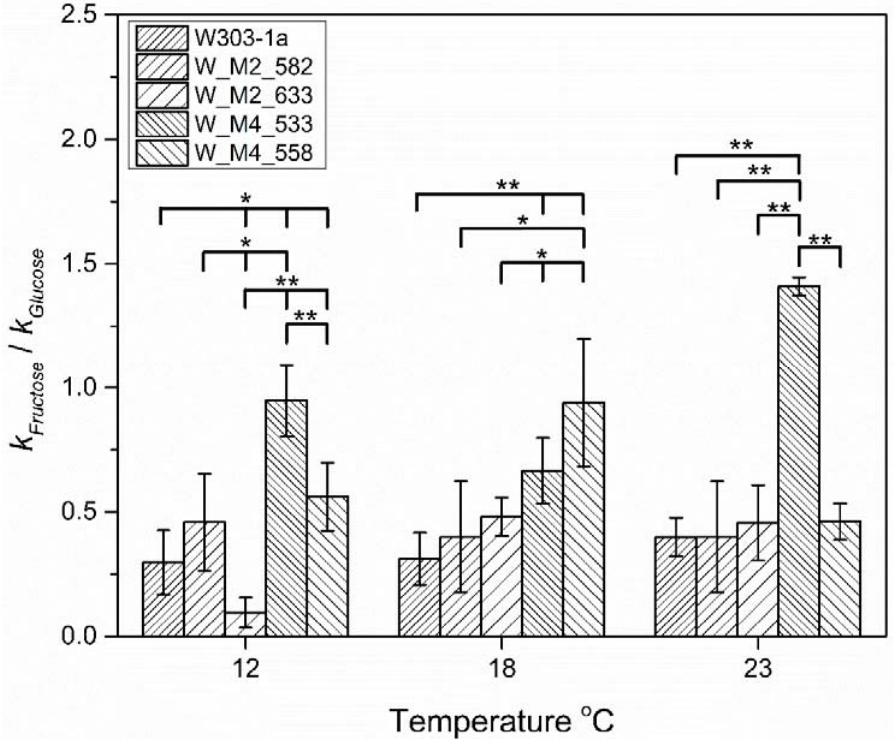
Figure 9. Reaction rate constants ratio, of fructose vs. glucose catabolism during lag phase for each strain at 12, 18 and 23 °C. The statistically significant differences are nominated by asterisks: (* p < 0.05, ** p < 0.01).